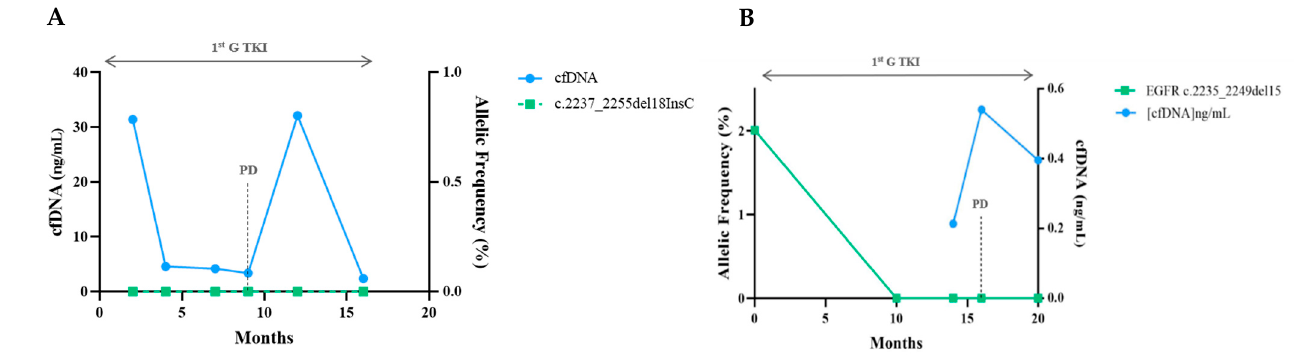
Figure 6. Example of “negative” patients. Despite fluctuations in cfDNA amount in ( A ), no mutations were detected. In ( B ), there was a complete clearance of the driver mutation with response to 1st G TKI, but no change nor a new alteration was stated when progression occurred.